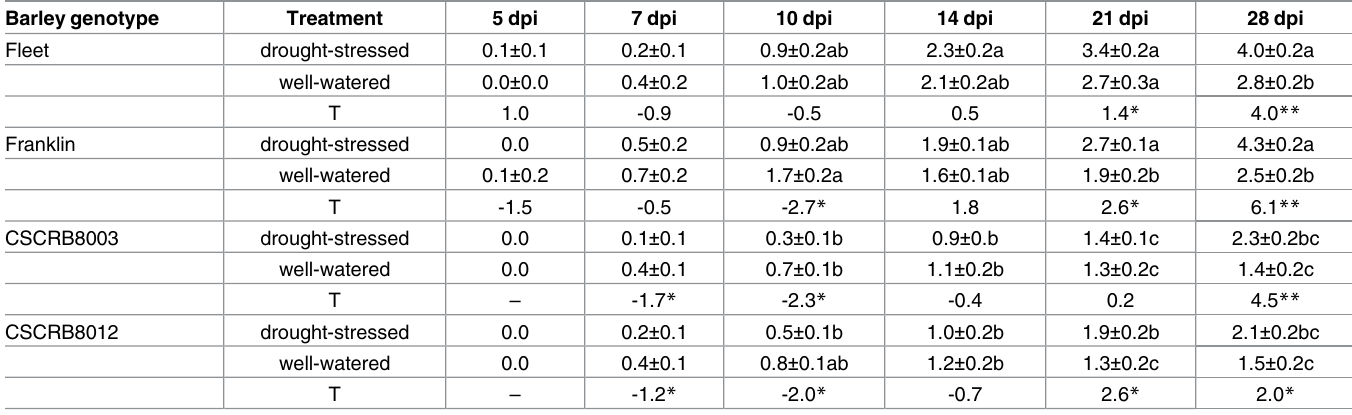
Table 1. Fusarium crown rot disease index (DI) of the four barley genotypes assessed at 6 different time points following inoculation a . Barley